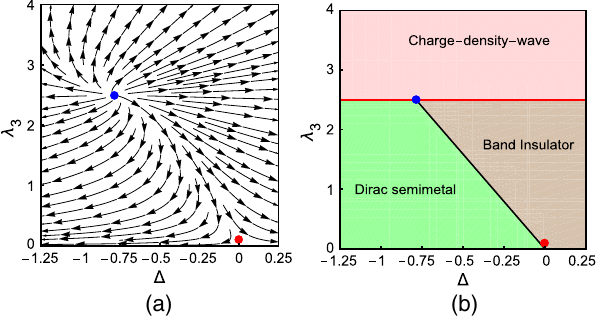
FIG. 7. (a) The renormalization group flow diagram obtained from Eq. (25) for spinless fermions. (b) The corresponding phase diagram. The red (blue) dot corresponds to the noninteracting critical (interacting multicritical) point. The (dimensionless) coupling constant λ 3 and band parameter (b) are measured in units of ϵ and, in the RG flow equations [see Eq. (25)], we substitute n ¼ 10 in f